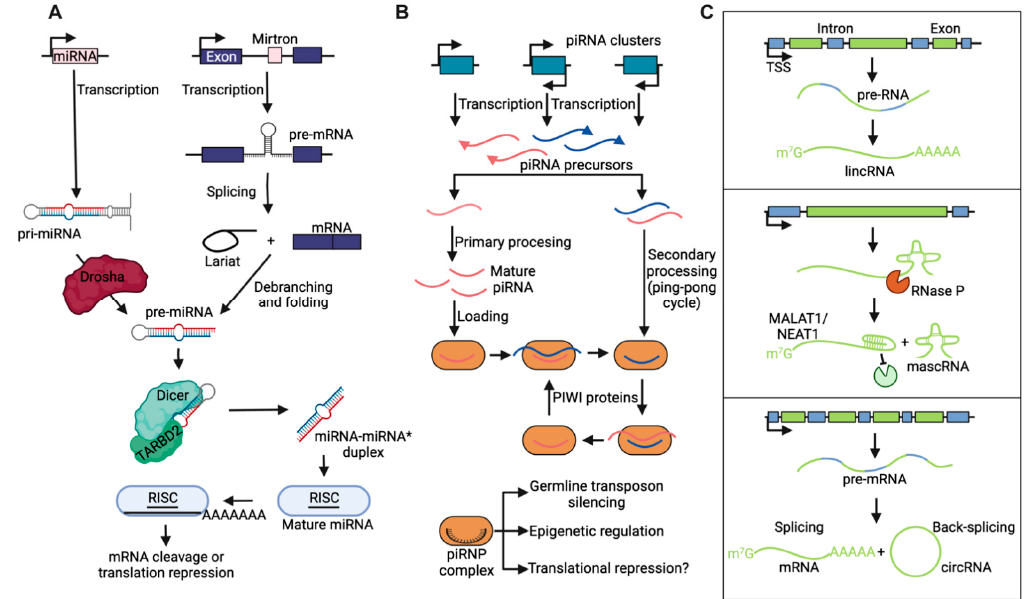
Figure 1. Biogenesis of small and long ncRNAs. ( A ) miRNAs are transcribed at independent loci (primary miRNA [pri-miRNA]) or together with host protein-coding genes (mirtrons). After processing by the Drosha complex or lariat-debranching enzymes, respectively, precursor miRNAs (pre-miRNAs) are shuttled to the cytoplasm for further processing by Dicer and TAR RNA-binding protein 2 (TARBP2). When two mature miRNAs originate from opposite arms of the same pre-miRNA, one mature species is typically more abundant than that derived from the opposite arm, in which case, an asterisk indicates the low abundant species. Following generation of mature miRNAs, which are loaded onto the RNA- induced silencing complex (RISC), miRNAs function through degradation of protein-coding transcripts or translational repression. ( B ) PIWI-interacting RNAs (piRNAs) are mostly expressed as ssRNAs from mono- or bidirectional clusters. Additional piRNAs may be produced through a PIWI-protein-catalyzed amplification loop (“ping-pong cycle”) via sense and antisense intermediates. The PIWI ribonucleoprotein (piRNP) complex functions in transposon repression through target degradation and epigenetic silencing. Roles of the piRNP complex in translation repression, if any, remain unknown. ( C ) (Top) Long intergenic ncRNAs (lincRNAs) are transcribed by Poll II from intergenic regions (>20 kb from closest protein-coding gene), and spliced, capped, and polyadenylated. (Middle) MALAT1 and NEAT1 are well-studied, highly conserved lncRNAs that are processed by RNase P and stabilized by U-A-U triple helix structures at their 3 (cid:48) ends. Their 3 (cid:48) -end products are further processed to form MALAT1-associated small cytoplasmic RNA (mascRNAs), which are ~60 nt in length and have unknown functions. (Bottom) Circular RNA (circRNAs) are produced from back-slicing circularization of exonic pre-mRNAs. During splicing, pre-mRNAs are spliced into linear, mature mRNAs or back-spliced into